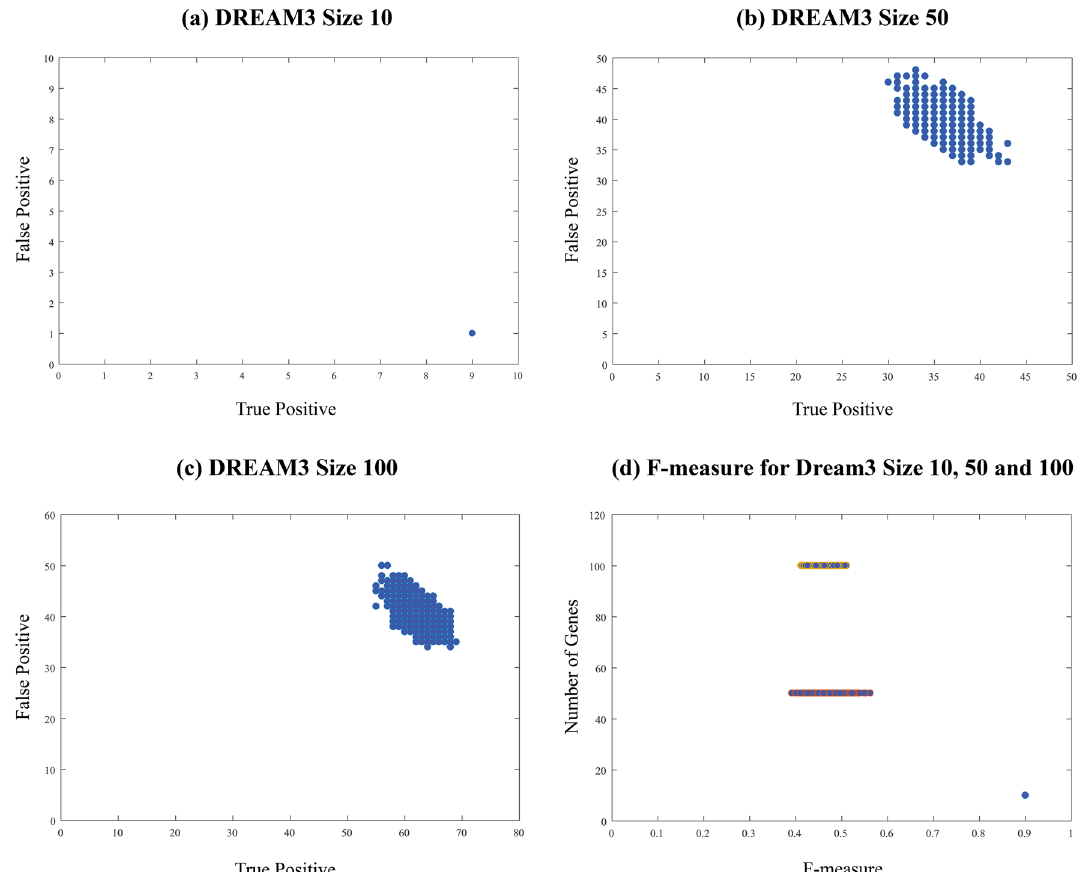
Figure 3. True Positive against False Positive for 1000 randomly-generated permutations for DREAM3 dataset with ( a ) 10 genes, ( b ) 50 genes, and ( c ) 100 genes resulted by PCA-CMI. The F-measure values for DREAM3 dataset with 10, 50 and 100 genes is represented in part ( d ).